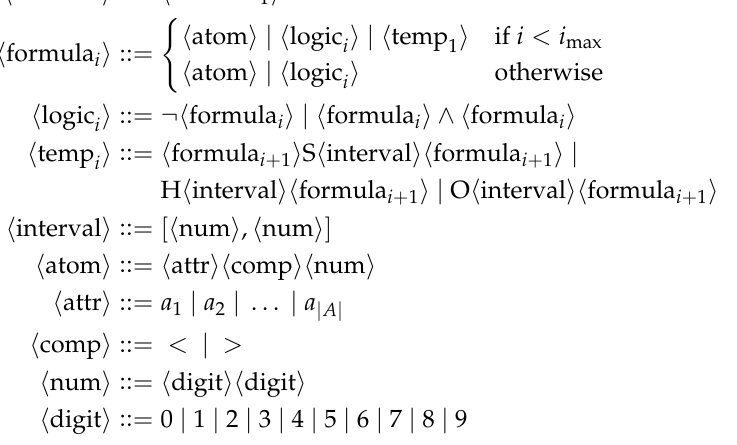
(cid:105) , (cid:104) temp (cid:105) are parametric on i , which represents i i